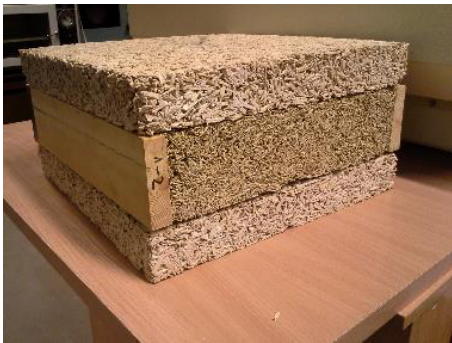
Fig. 5. Experimental sandwich hemp-magnesium sandwich panel (sample with various density hemp concrete).